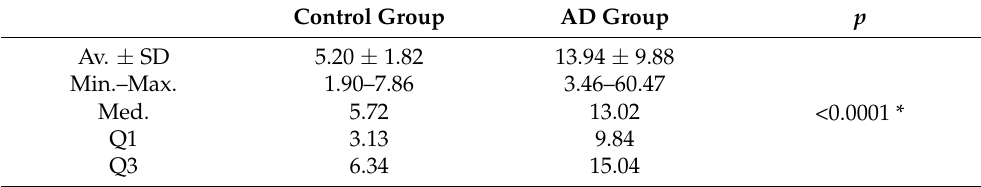
Table 5. Proteasome concentration [ µ g/mL] in the test group compared to the control